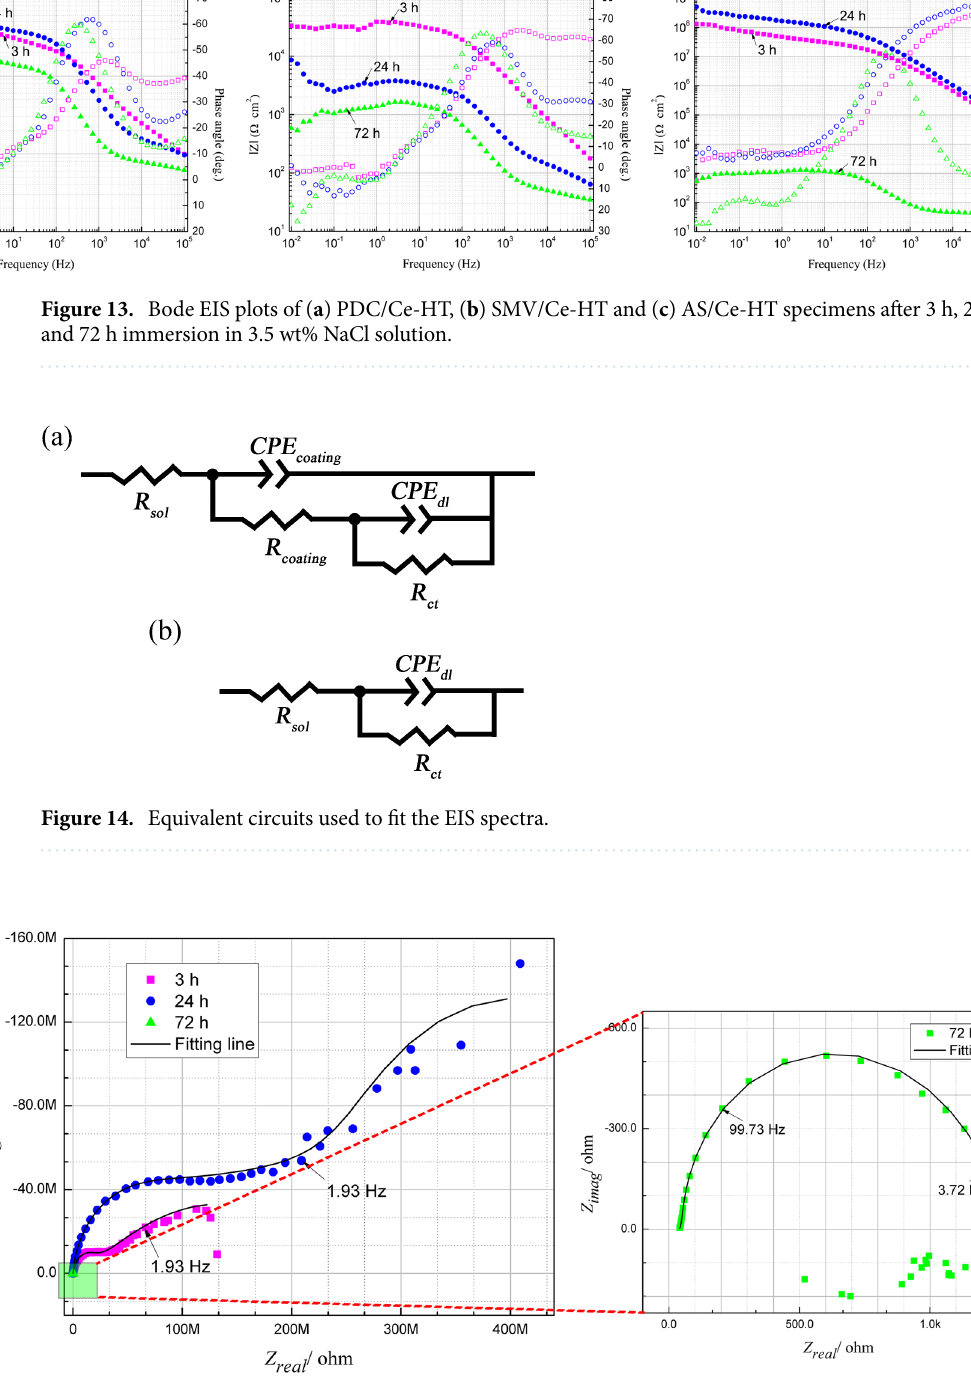
Figure 15. Nyquist plot of AS/Ce-HT specimen and the fitted result using equivalent circuits shown in Fig. 14.